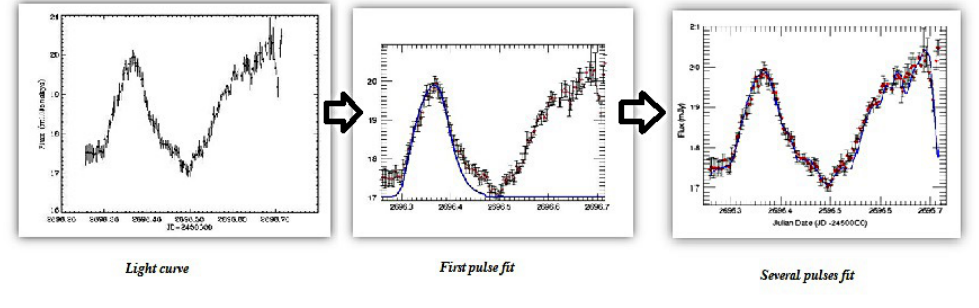
Figure 6. The process of fitting pulses to actual micro-variability curves. The light curve is an actual micro-variability curve of S5 0716+71 that has been linearized and fit with individual pulses. The process is currently done by eye, but will soon be automated using a smart fitting routine.